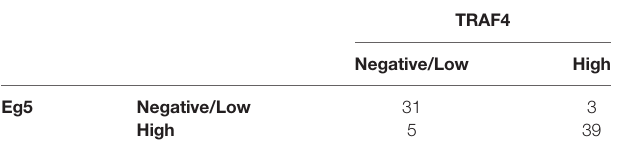
TABLE 2 | Correlation between TRAF4 and Eg5 protein level in breast cancer